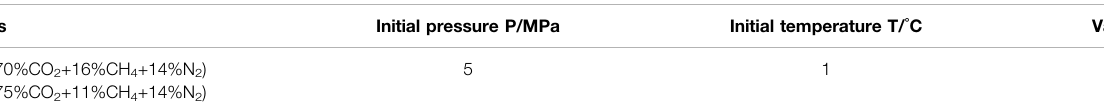
TABLE 1 | The initial conditions for hydrate synthesis.